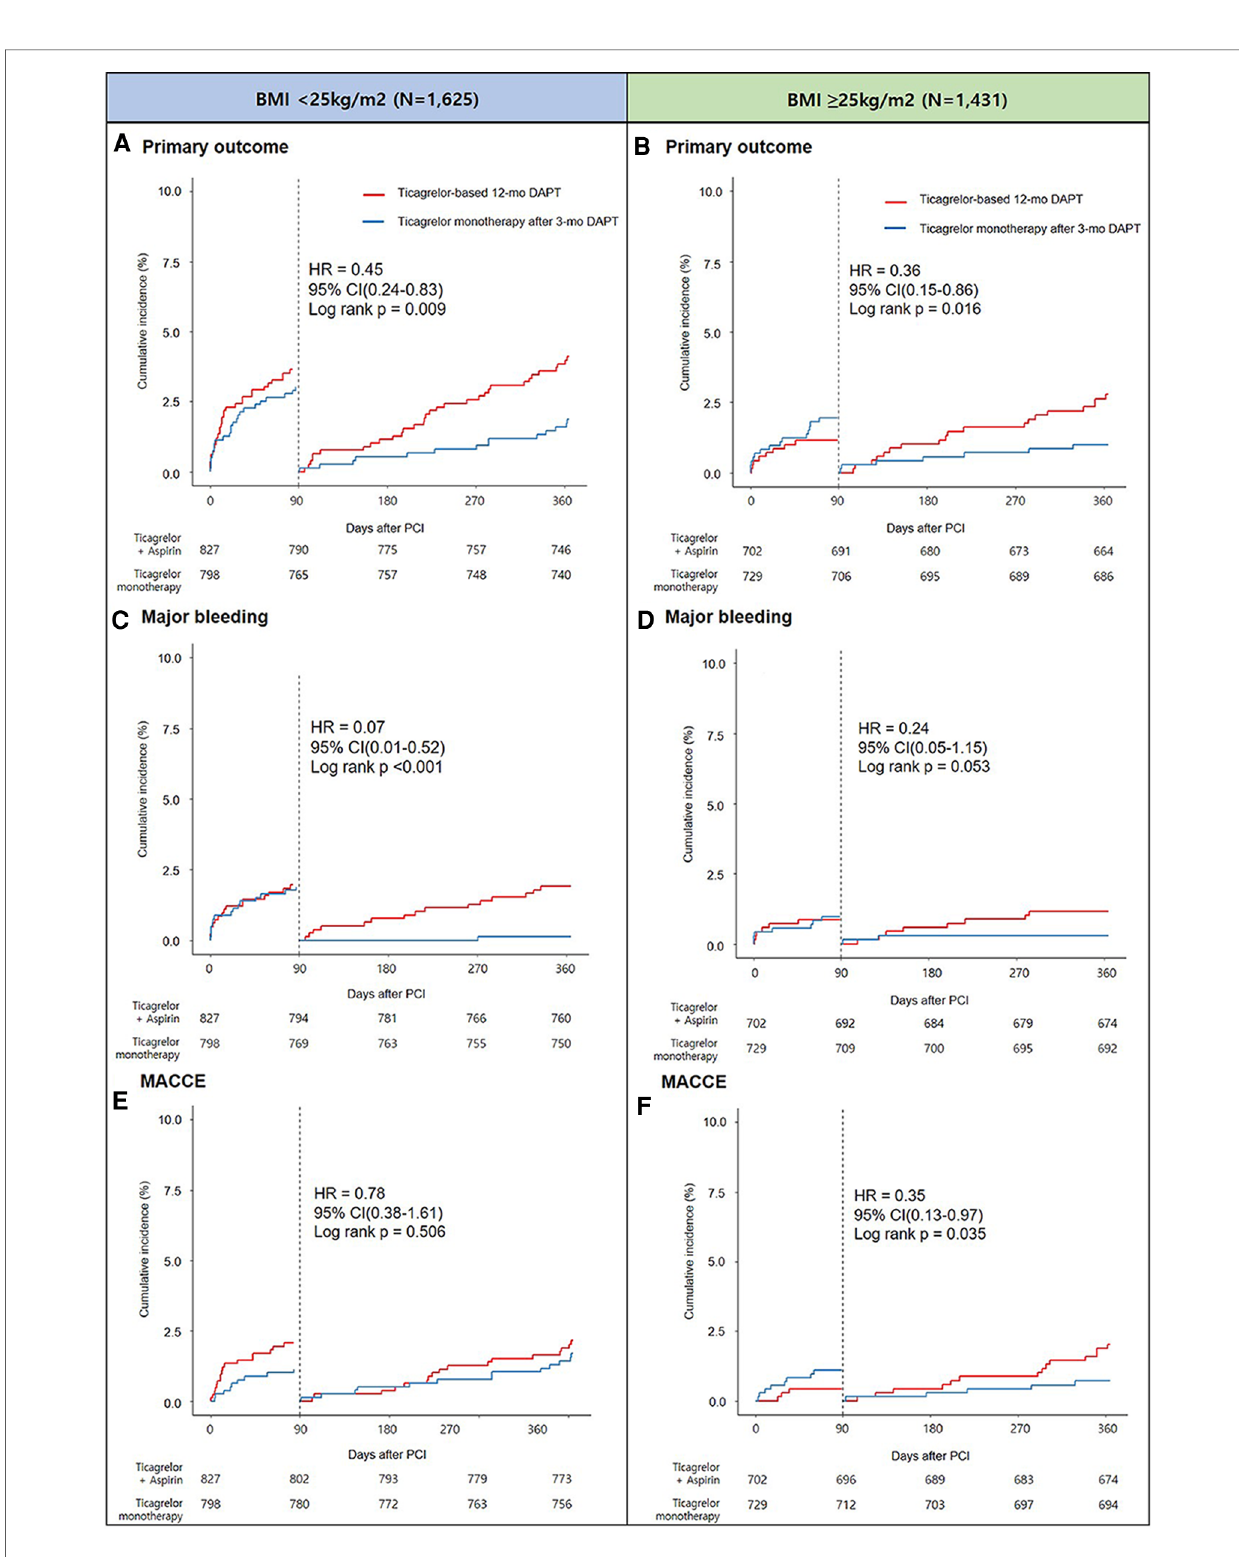
FIGURE 4 Landmark analysis at 3 months and Kaplan-Meier estimates for primary outcome in patients with BMI <25 kg/m 2 ( A ) and BMI ≥ 25 kg/m 2 ( B ), major bleeding in patients with BMI <25 kg/m 2 ( C ) and BMI ≥ 25 kg/m 2 ( D ), and MACCE in patients with BMI <25 kg/m 2 ( E ) and BMI ≥ 25 kg/m 2 ( F